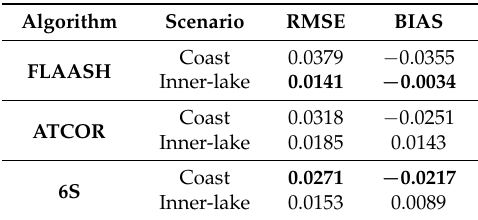
Table 4. RMSE and BIAS between the in-situ measurements and satellite corrected reflectance for each atmospheric algorithm (best results in bold).